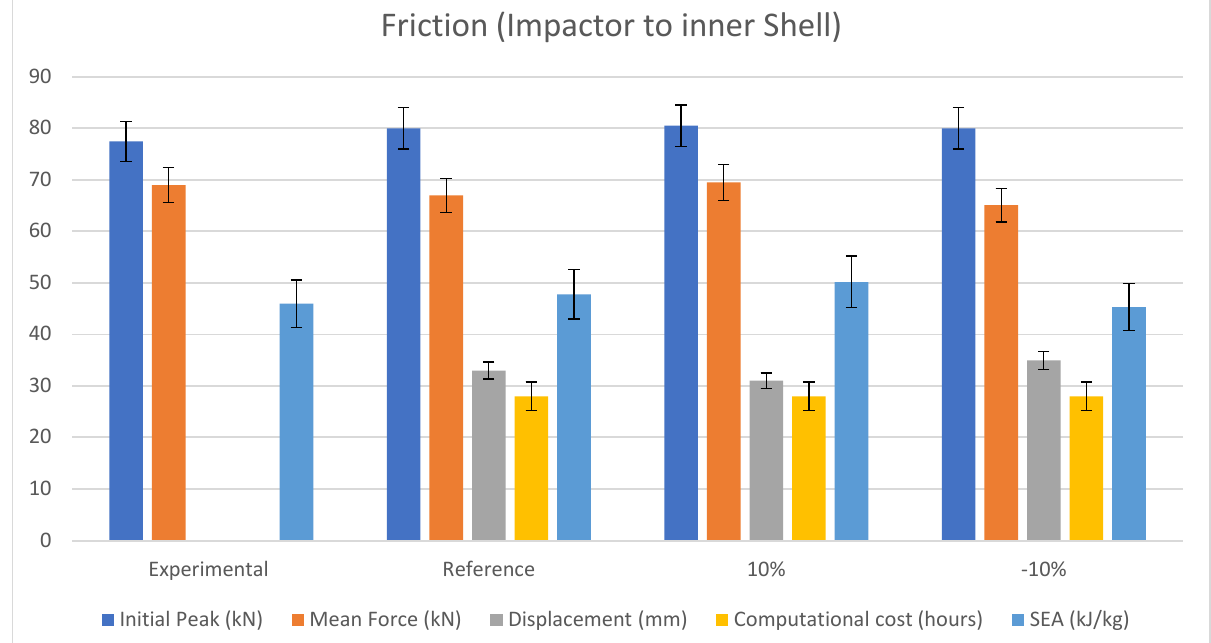
Figure 20. Impactor to inner-shell friction coefficient comparison [66].